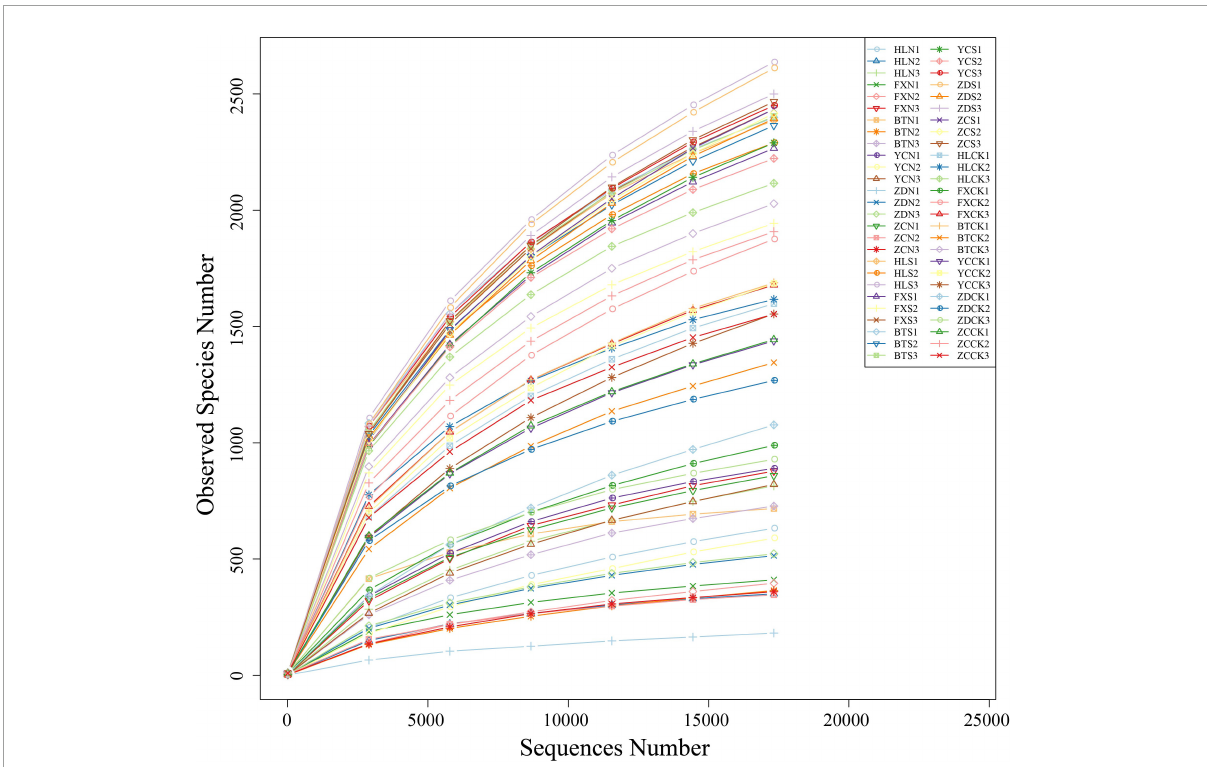
FIGURE2 Rarefaction curves based on the sequences of the V3+V4 region of the 16S rRNA gene from samples associated with S . davidii . HLN, FXN, BTN, YCN, ZDN, and ZCN indicate root nodule samples from the six sampling sites. HLS, FXS, BTS, YCS, ZDS, and ZCS indicate the rhizosphere soil samples of the six sampling sites. HLCK, FXCK, BTCK, YCCK, ZDCK, and ZCCK indicate the bulk soil samples of the six sampling sites. N =